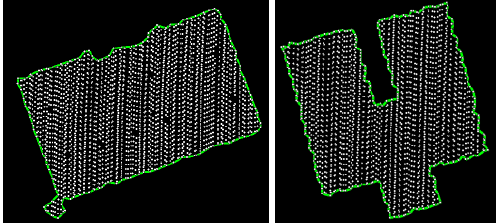
Figure 4. The concave hull line of the buildings